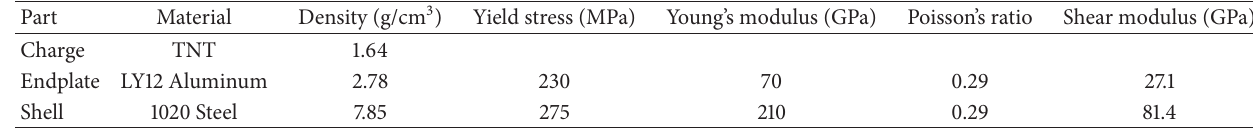
Table 1: Material properties of the asymmetric